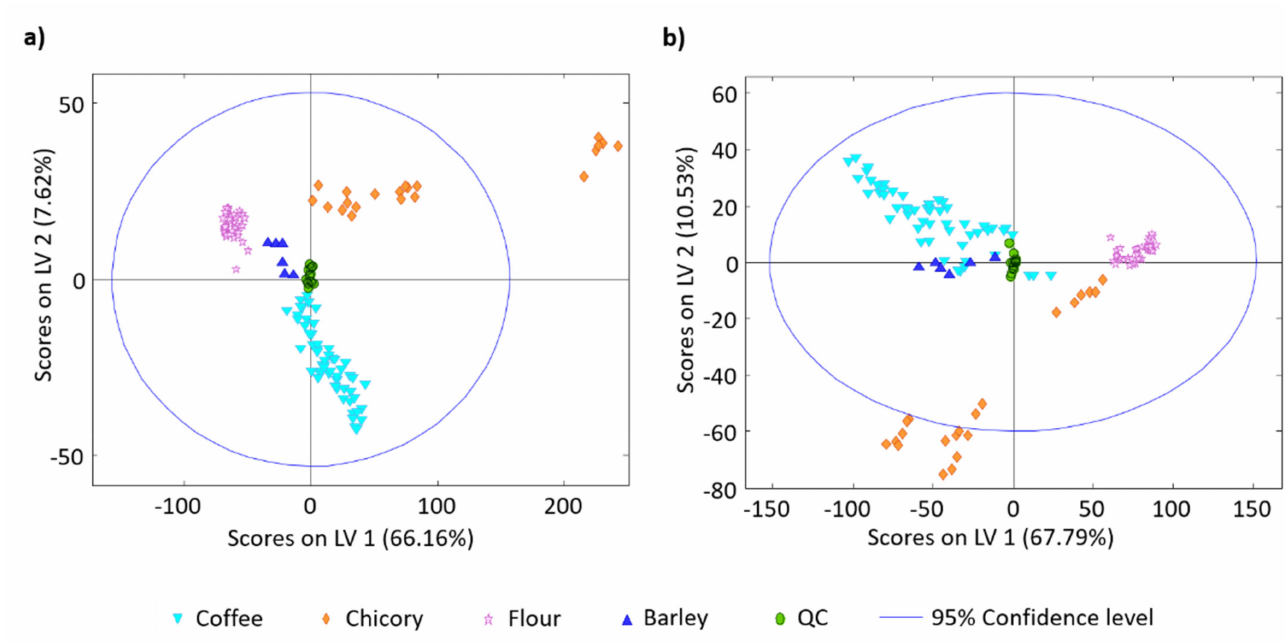
Figure 3. Partial least squares regression-discriminants analysis (PLS-DA) score plots of LV1 vs. LV2 for the classification of the analyzed samples when untargeted ( a ) HPLC-UV and ( b ) HPLC-FLD fingerprints were employed as sample chemical descriptors. PLS-DA models were built with 2 and 3 LVs for HPLC-UV and HPLC-FLD,